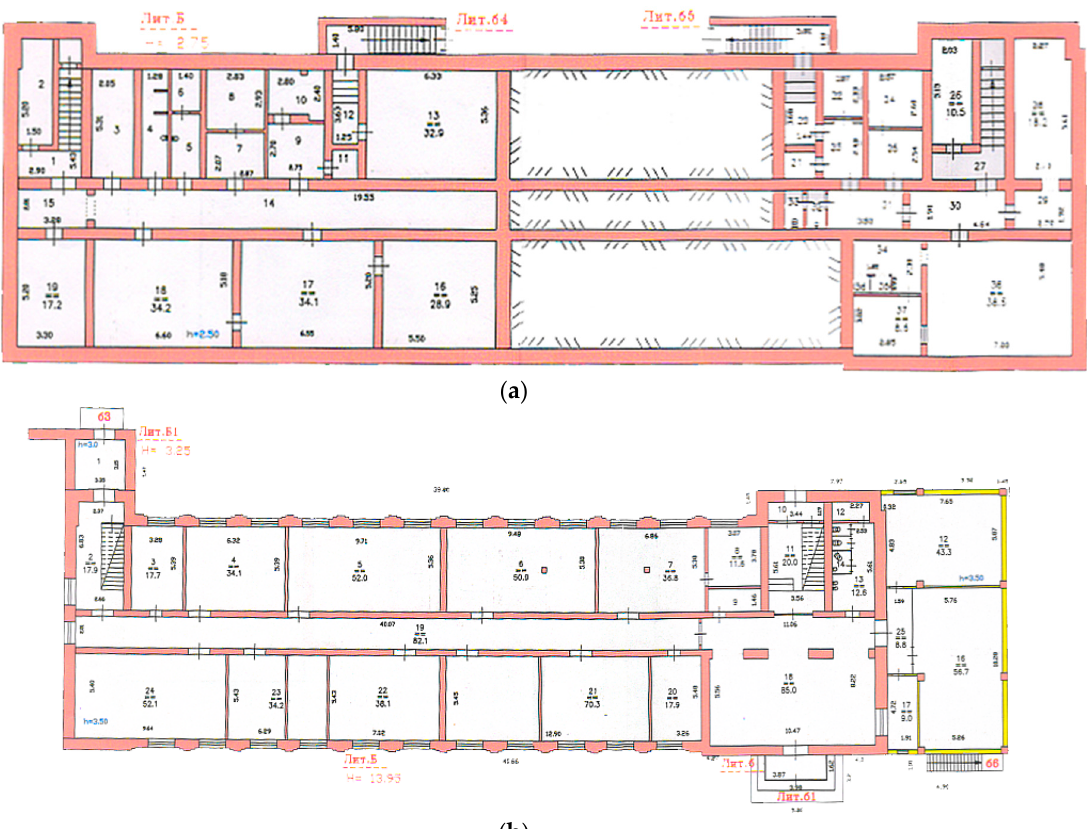
Figure 3. The plan of 3-story brick building with a ribbon foundation under study: ( a ) The building basement plan; ( b ) The 1st floor plan. basement plan; ( b ) The 1st floor